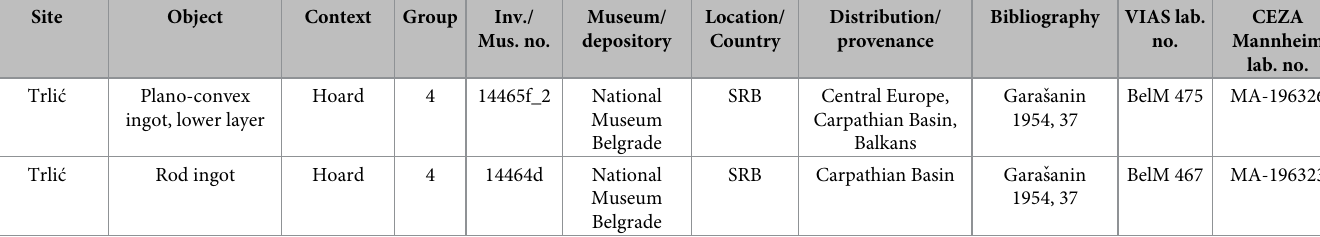
rivets (Fig 2: 6) are good examples of such local adaptations [41] [53]. The sword of Aranyos type from the Drina River (Fig 2: 2) is also most probably a local product with nearest analo- gies in Bosnia, Croatia and Serbia [41, 54].